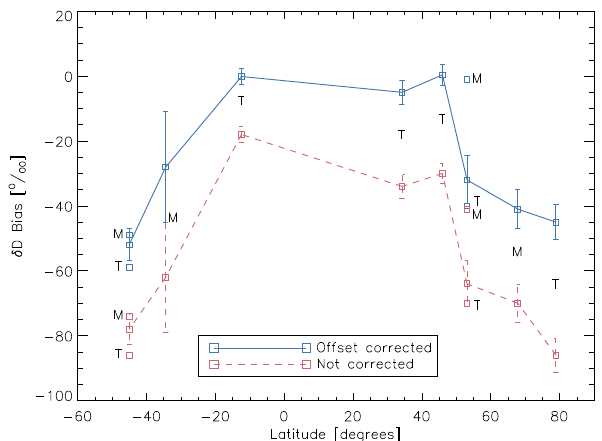
Figure 7. Bias as a function of latitude for all low-altitude TCCON and MUSICA stations. The letters “T” and “M” indicate a TCCON and MUSICA station respectively. For Lauder ( − 45 ◦ ) and Bremen ( + 53 ◦ ) the results from both networks are shown separately, but the curve follows the weighted average of both networks.